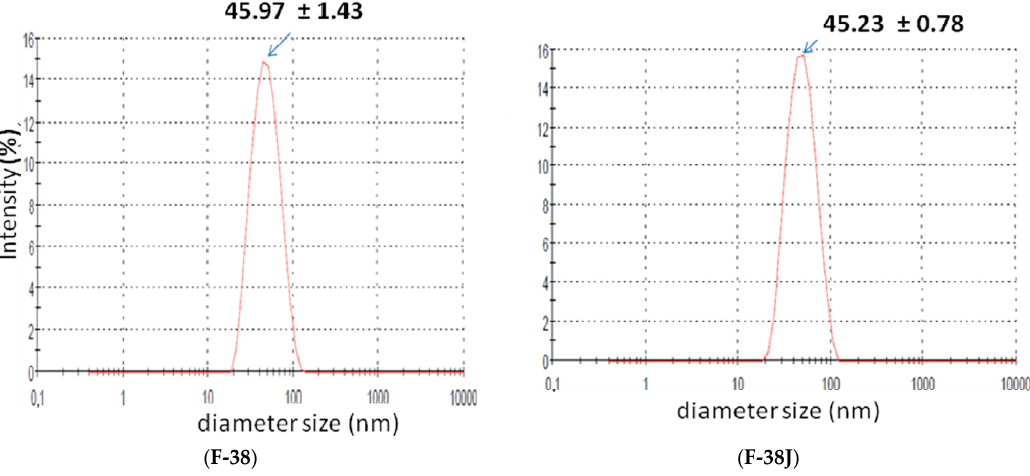
Figure 2. Particle size distribution comparison for babassu oil nanoemulsion without ( F-38 ) and with ( F-38J ) vegetable extracts.